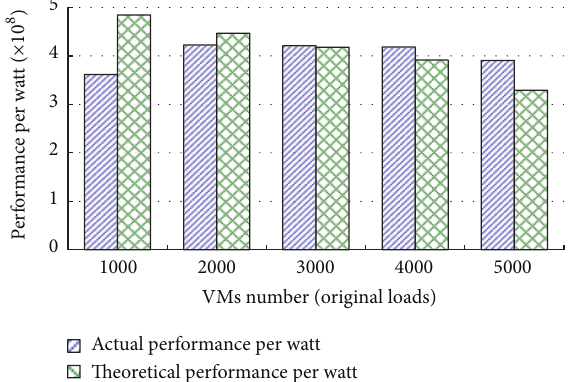
Figure 5: Comparison of actual performance per watt and theoret- ical performance per